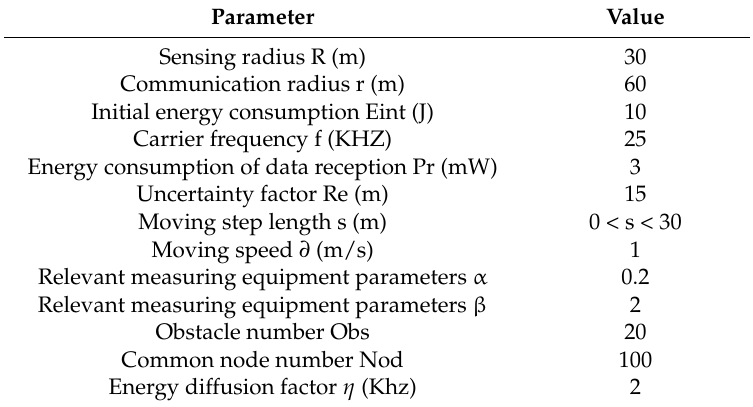
Table 1. Simulation